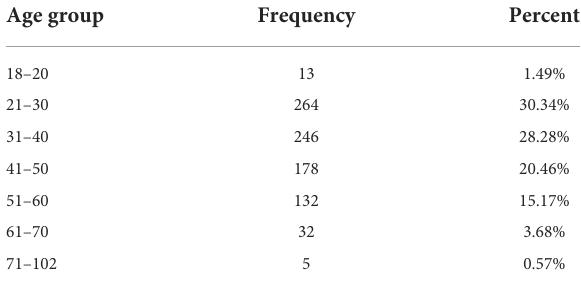
TABLE 2 Frequency of age groups of AKC Junior survey